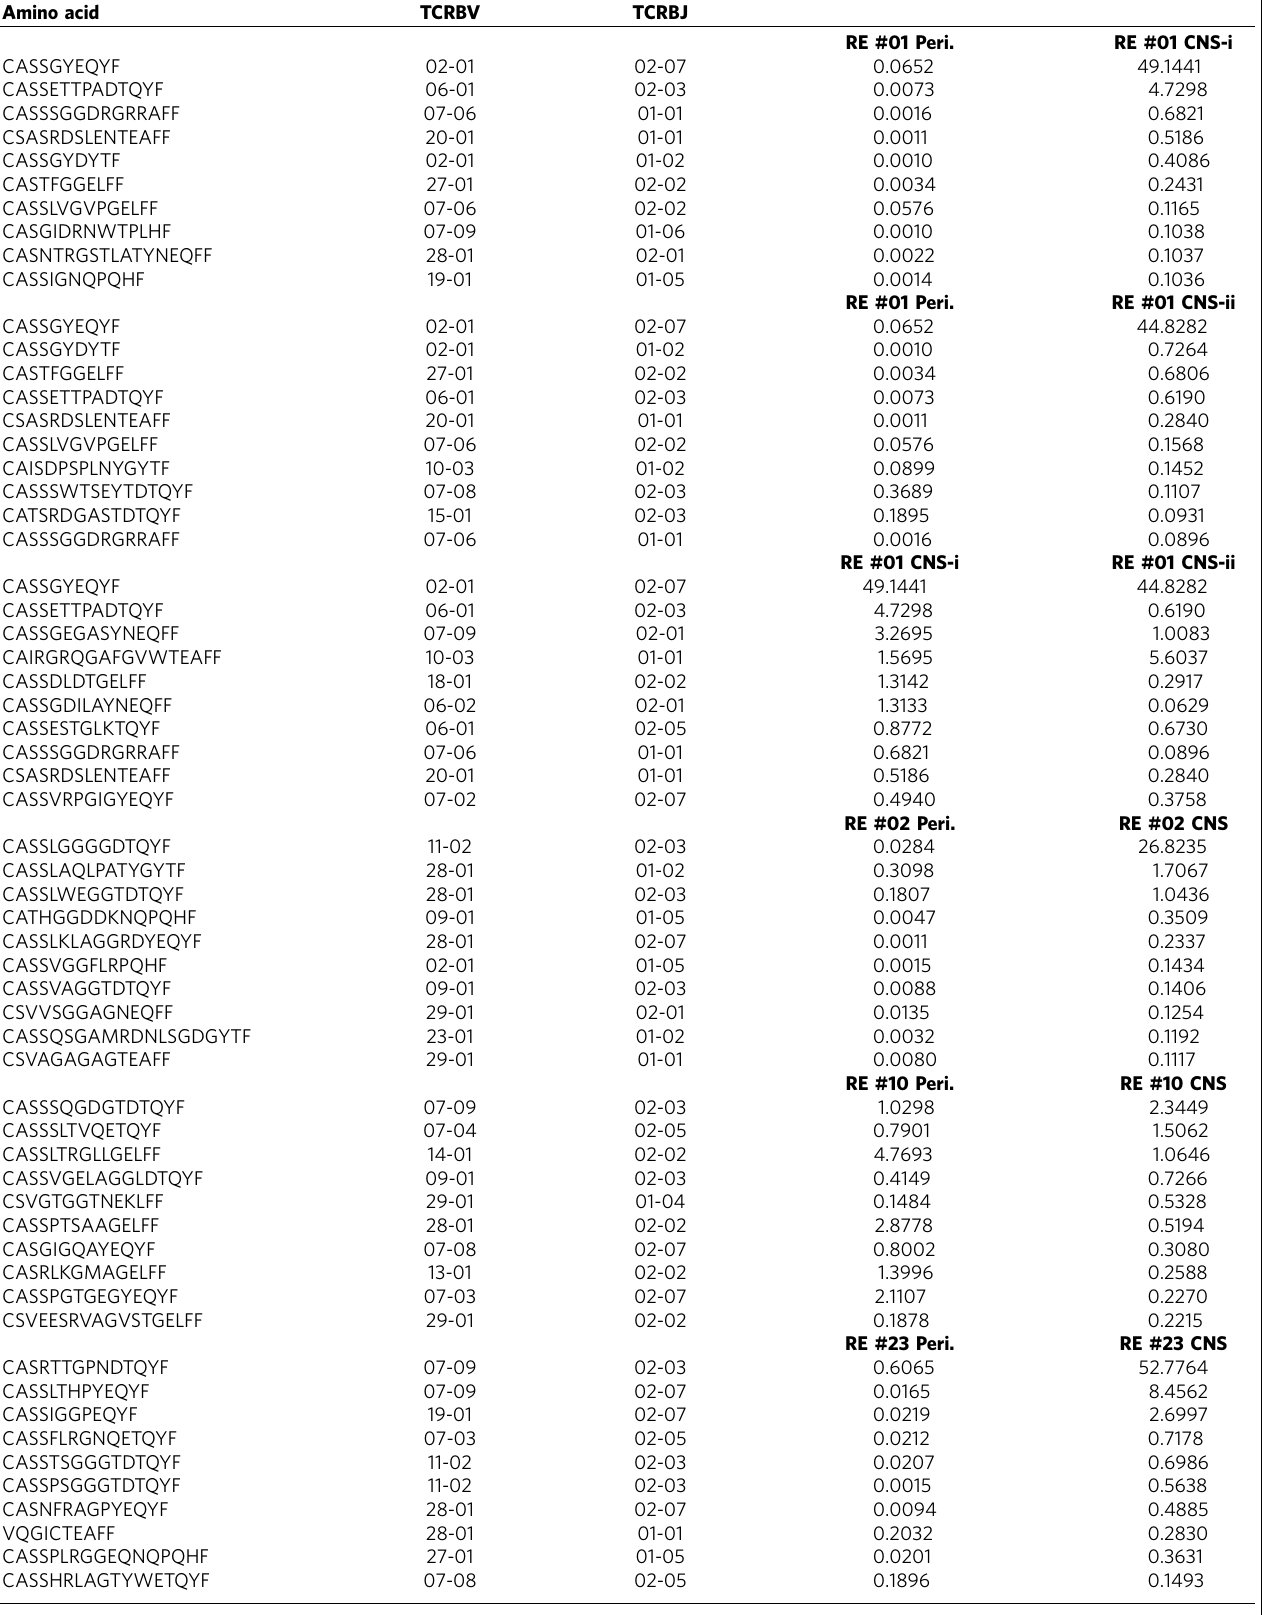
Table 1 | Sequence detail of T-cell clones shared between CNS and peripheral blood. Amino